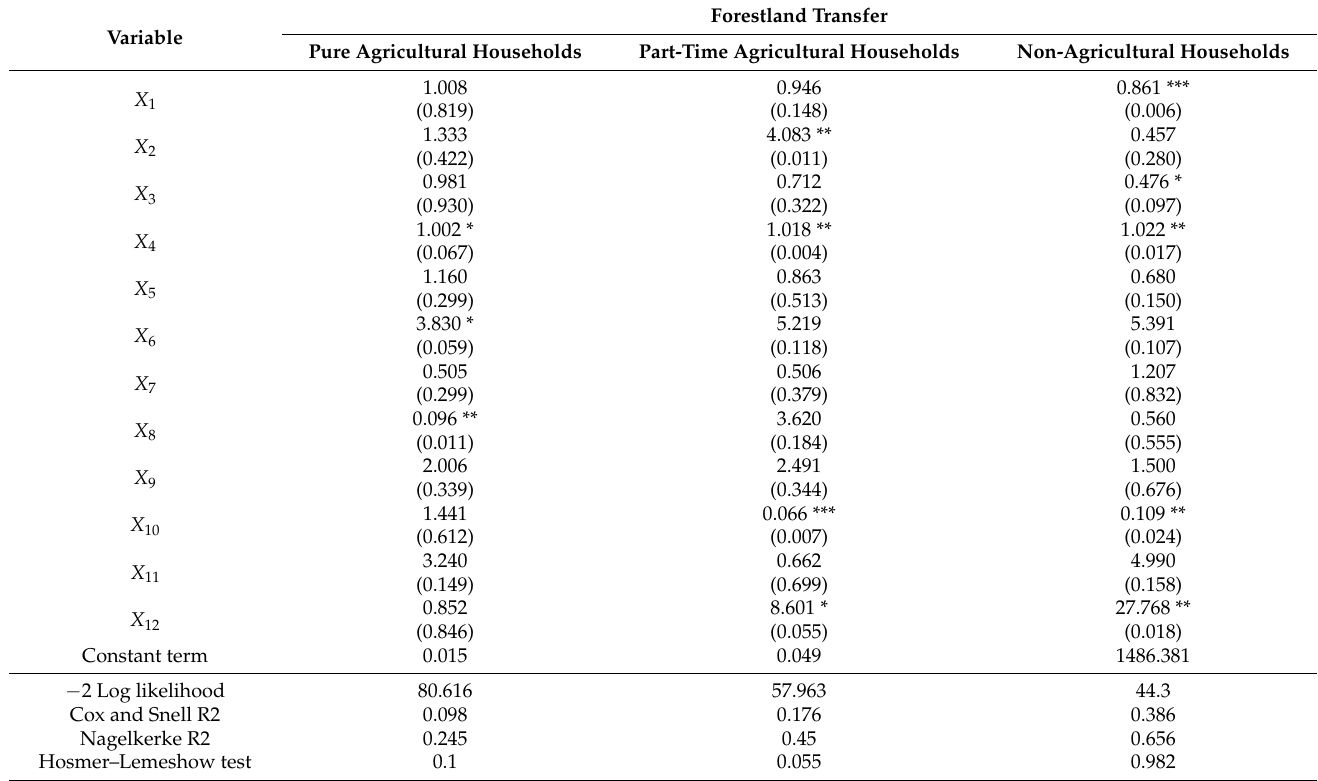
Table 9. The results of logistic regression analysis ( n =